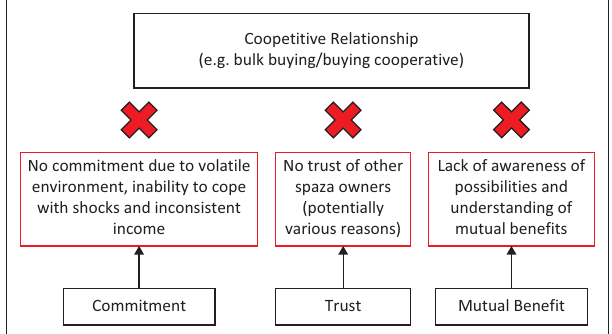
FIG URE 2: Barriers to